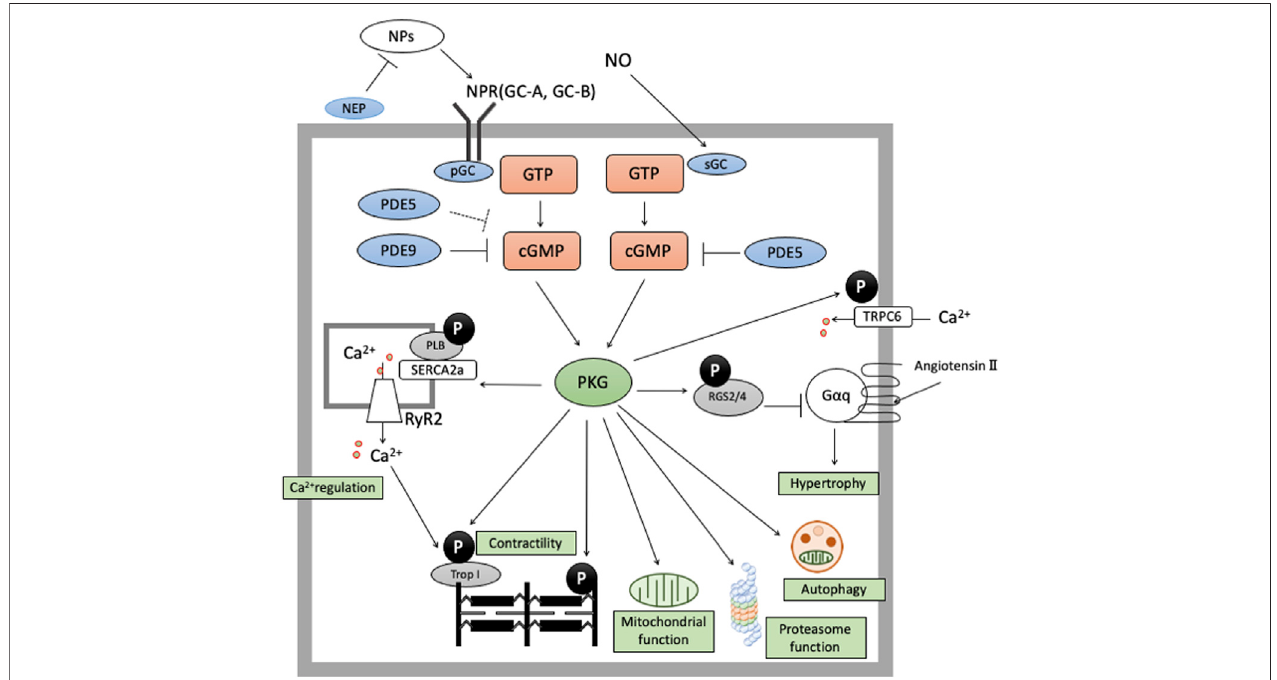
FIGURE 1 | cGMP/PKG signaling in cardiomyocyte cGMP-PKG signaling is enhanced by two pathways. The former is NO-sGC-cGMP pathway and the latter is NP-NPR-pGC pathway. cGMP derived from NO-sGC pathway takes hydrolyzation by PDE5, and cGMP from NP-pGC pathway by PDE9 and PDE5 (especially in stressed conditions). cGMP/PKG signaling exerts protective effects in cardiomyocyte by phosphorylate various proteins like RGS2/4, Troponin I, TSC2, cMyBP-C, or